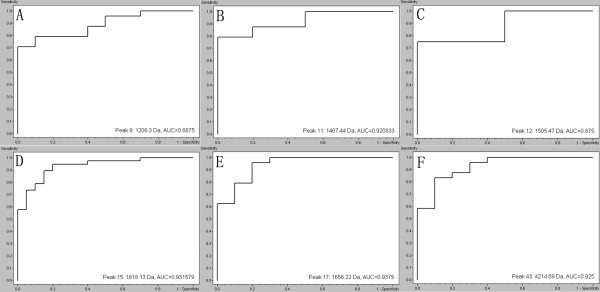
Receiver operating characteristic curve of the six proteins (m/z 1208 (A), 1467 (B), 1505 (C), 1618 (D), 1656 (E) and 4215 (F)) selected for the diagnostic model. AUC, Areas under the receiver operating characteristic curve.